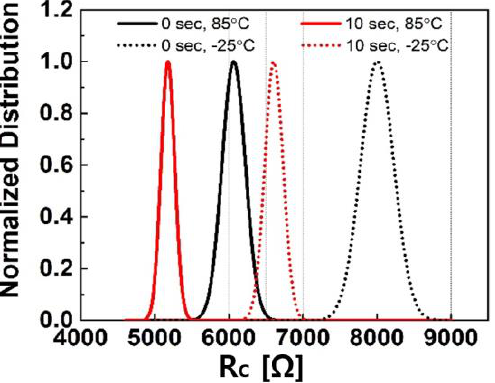
Figure 4. Normalized median and distributions plot of the contact resistances with different tempera- tures and the processing time.